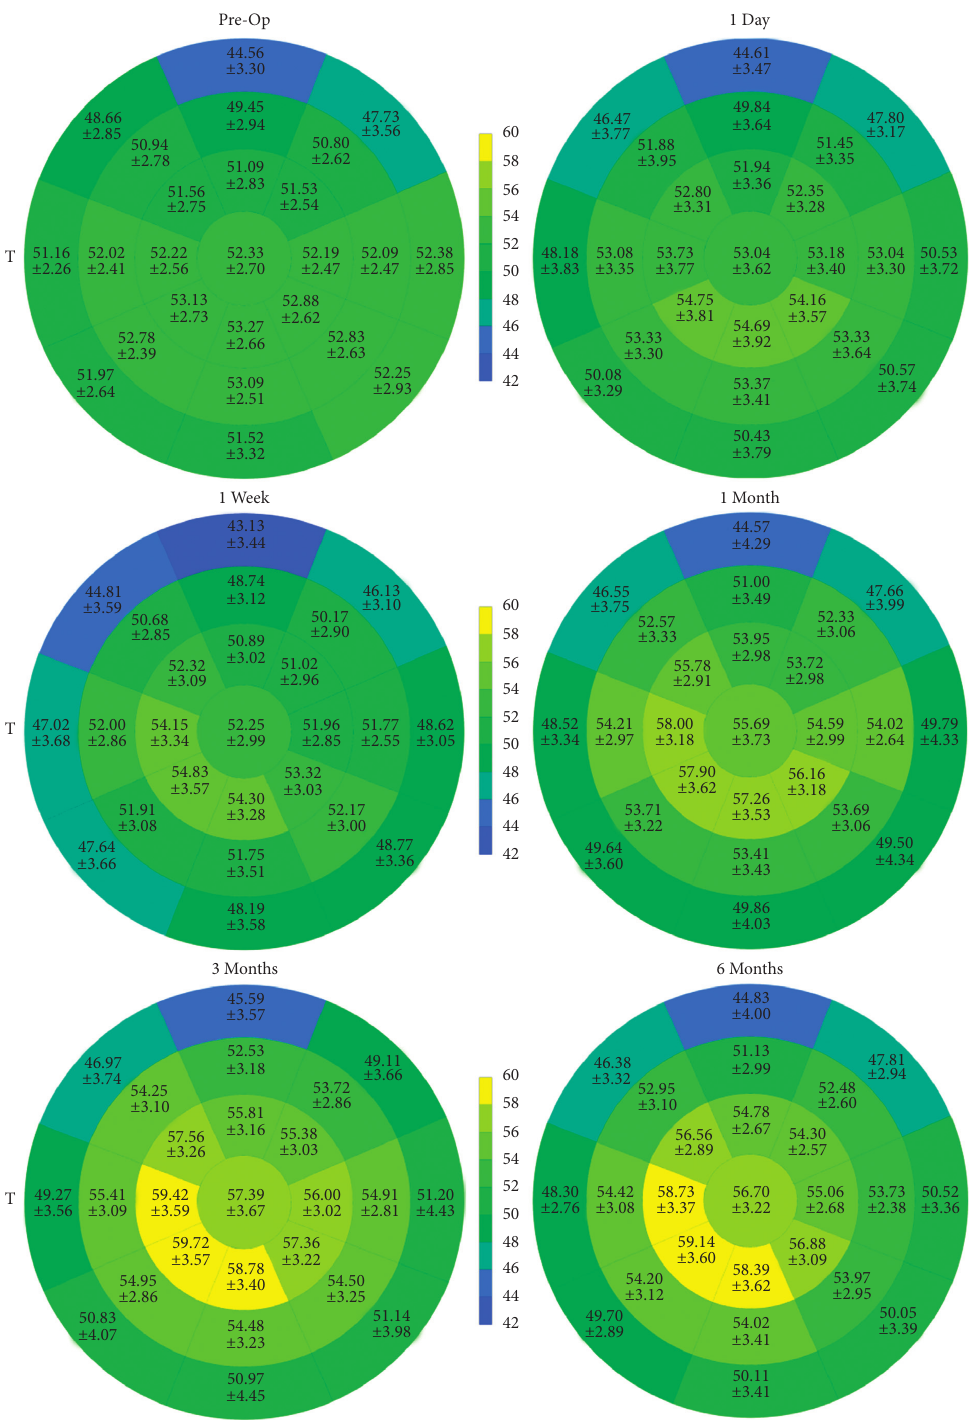
Figure 1: Preoperative to six-month postoperative 9mm diameter epithelial thickness map. The corneal epithelial thickness of all 25 sections was presented by the mean and standard deviation ( n � 64 eyes). N: nasal; T: